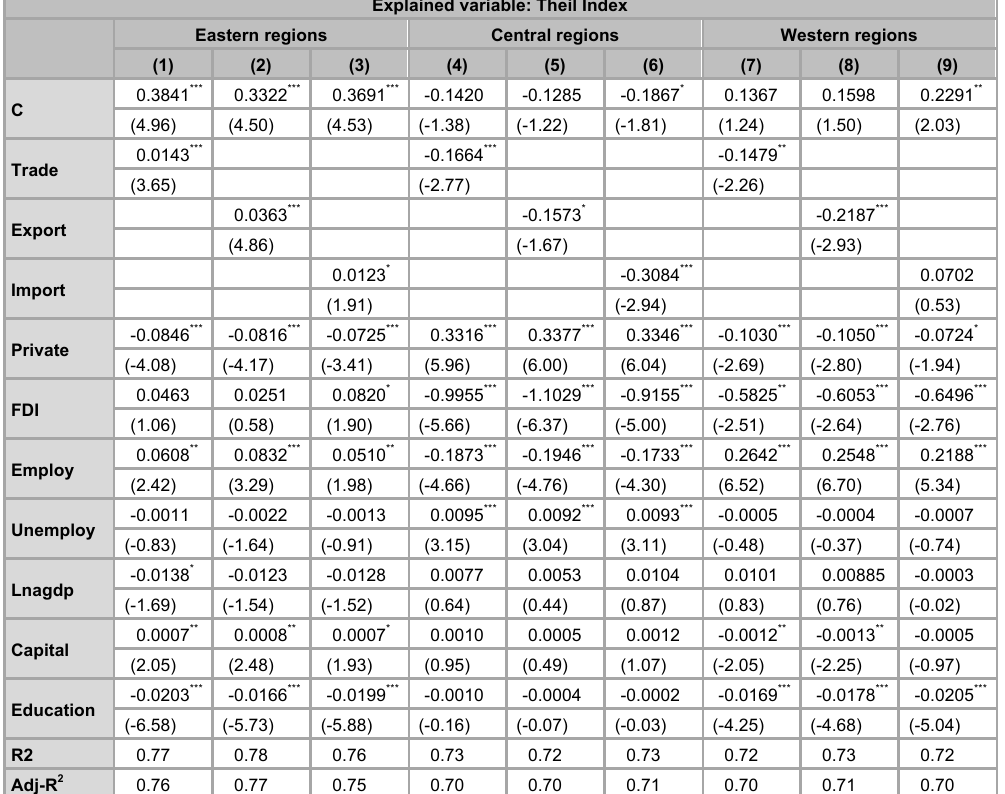
Regression results (2) of trade openness and the urban-rural income gap at regional level, spanning from 1986 to 2000 Explained variable: Theil